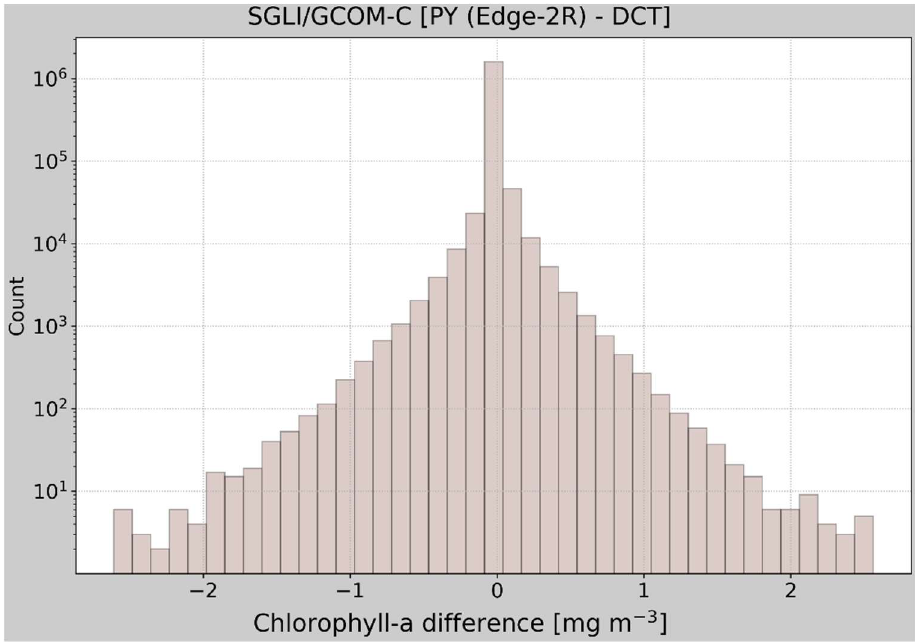
Figure 4. Chlorophyll-a difference between PY (Python-based) and DCT (JAXA’s Earth Observation Data Conversion Tool based) remapped data. Note the logarithmic scale on the y -axis.